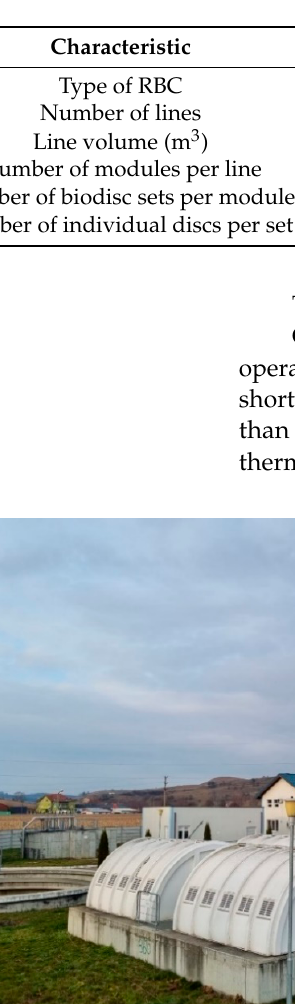
Table 2. Biodisc characteristics.